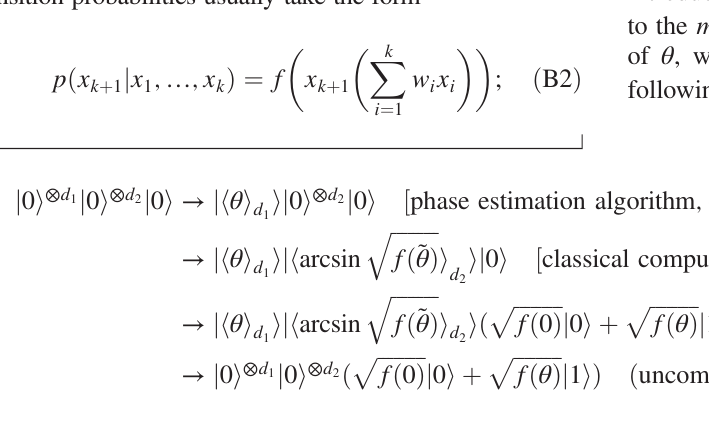
P w x gate. This gate can be implemented directly on a Rydberg-atom-based z ð i i Þ i